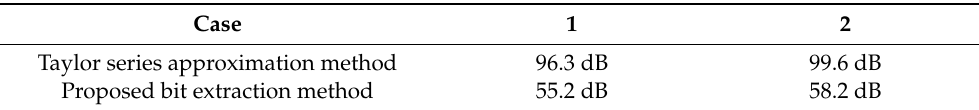
Table 1. Comparison of PSNR values of Taylor series approximation and proposed bit extraction methods with two phantom data sets.